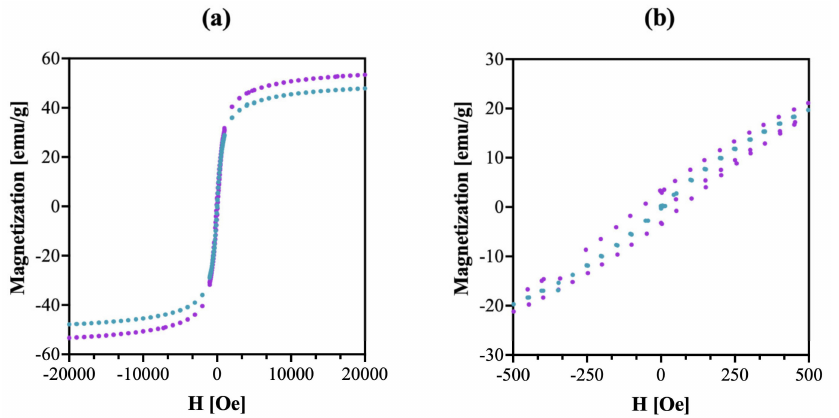
Figure 3. Magnetization isotherm for SPION@Au nanoparticles. Full hysteresis ( a ), fragment − 500–500 Oe, ( b ). . . . . . . 100 K, . . . . . . 300 K.